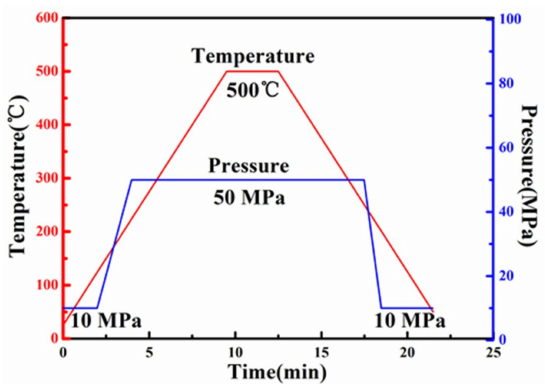
Figure 2. Diagram of variations in temperature and pressure during